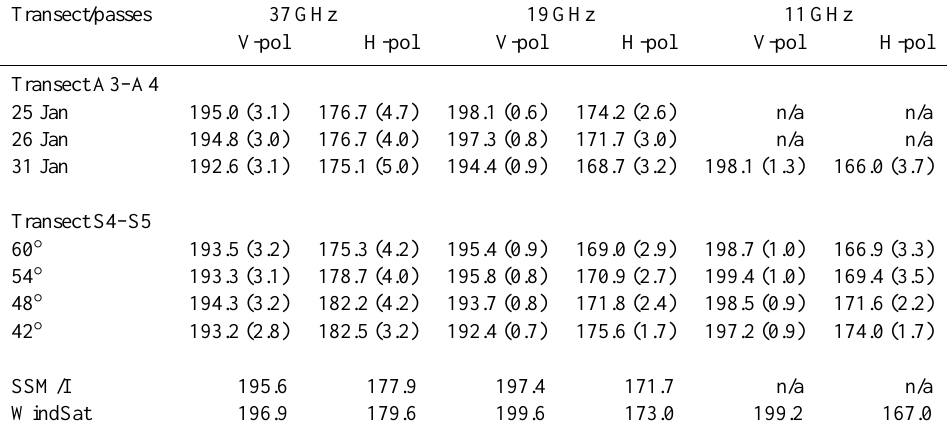
Table 1. Mean and standard deviation (in parentheses) of the brightness temperatures for the A3–A4 (at different dates) and S4–S5 (at dif- ference incidence angles) transects; mean brightness temperatures measured by SSM/I and WindSat during the field campaign and corrected for the upwelling atmospheric contribution and the transmission through the atmosphere.